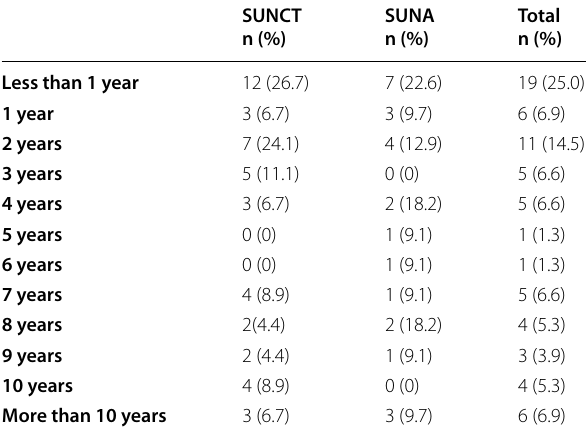
Table 3 Time delay for correct diagnosis of SUNCT and SUNA